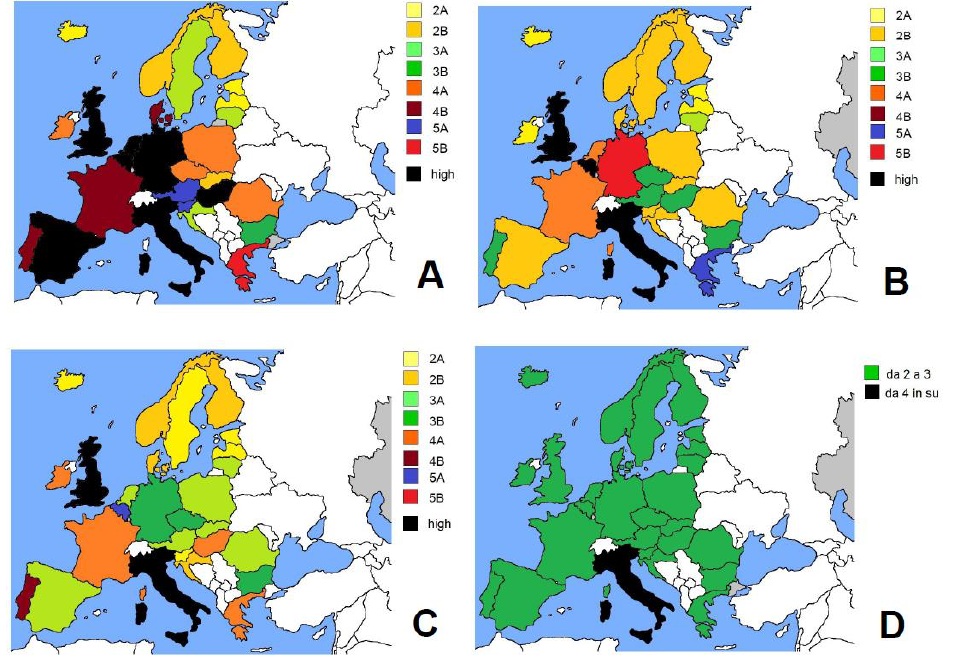
Figure 2. Maps of different COVID-19 waves: ( A ) 1st, ( B ) 2nd, ( C ) 3rd and ( D ) 4th. For details, see